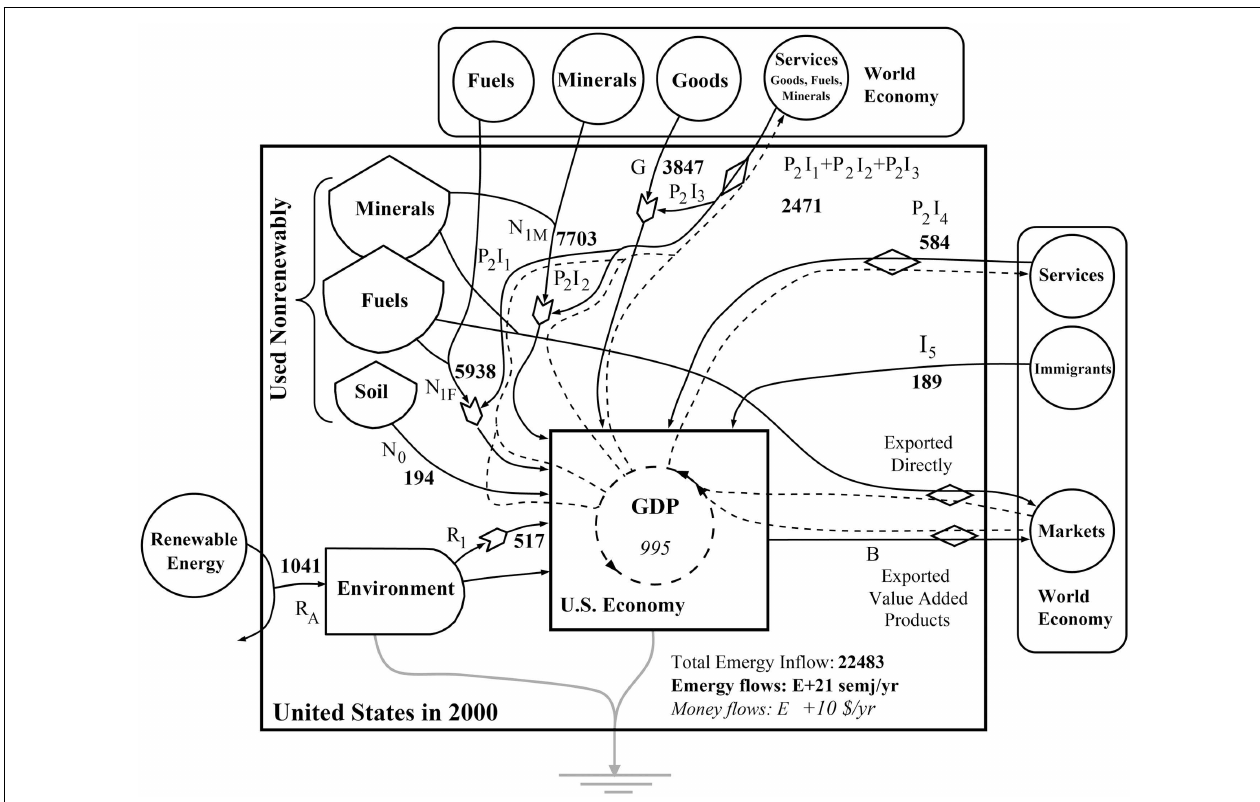
FIGURE 3 |An ESL diagram of the emergy basis for the Untied States evaluated for the year 2000 is shown . ESL symbols are defined in Odum (1983) and briefly in the caption of Figure 1